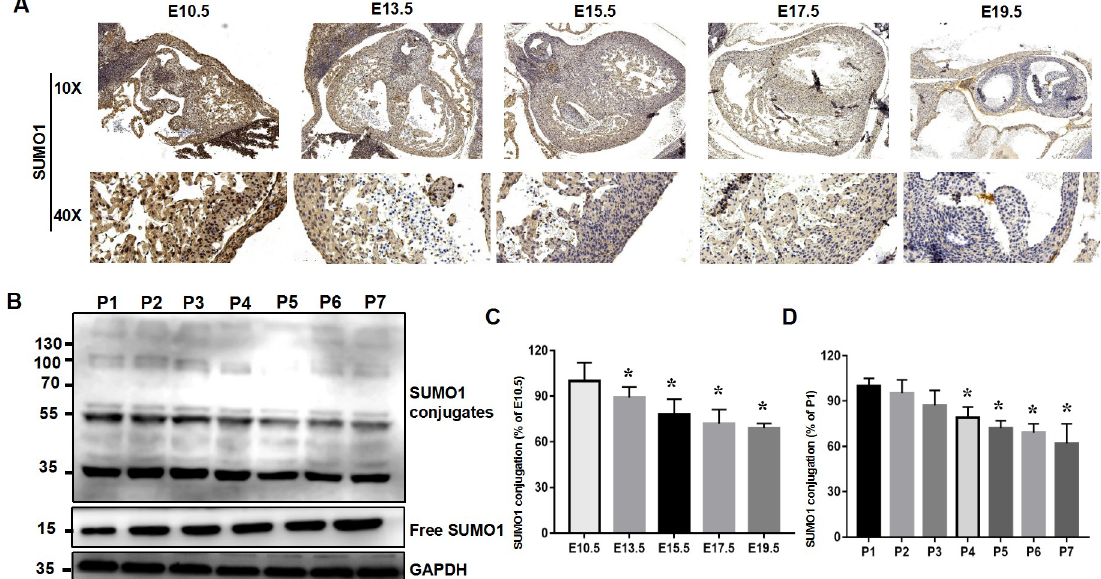
Fig 1. Spatiotemporal distribution characteristics of SUMO1-modified proteins during fetal mouse development. (A) Immunohistochemistry of SUMO1-modified proteins from E10.5 to E19.5 (n = 4). (B) Western blotting of SUMO1-modified proteins and free SUMO1 from P1 to P7 (n = 6). (C) Quantitative analysis of SUMO1-modified proteins in (A) by ImageJ software. Data are presented as the mean ± SD. A significant change was observed at E10.5. � P < 0.05 vs. E10.5. (D) Quantitative analysis of conjugated SUMO1 protein expression in (B). Decreases of conjugated SUMO1 proteins were quantified at P1–P7. Statistical significance of conjugated SUMO1 protein at P7 was analyzed by Tukey’s test. Values are presented as the mean ± SD. � P < 0.05 vs. P1.